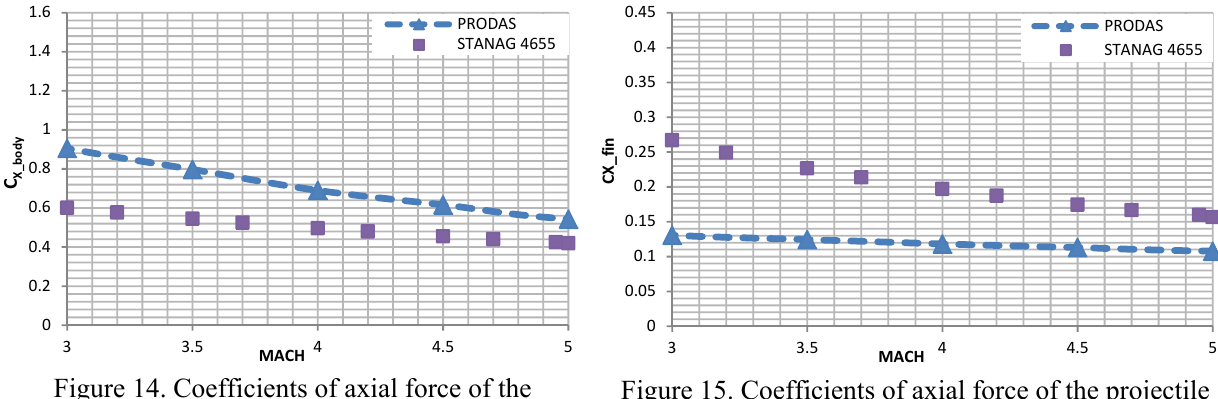
Figure 15. Coefficients of axial force of the projectile fins (120 mm,